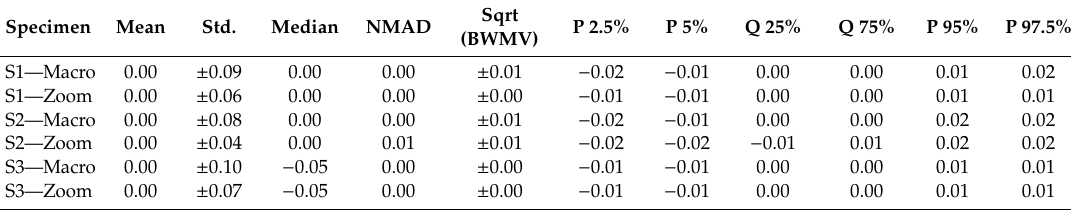
Table 6. Statistical analysis of the signed discrepancies. Units: